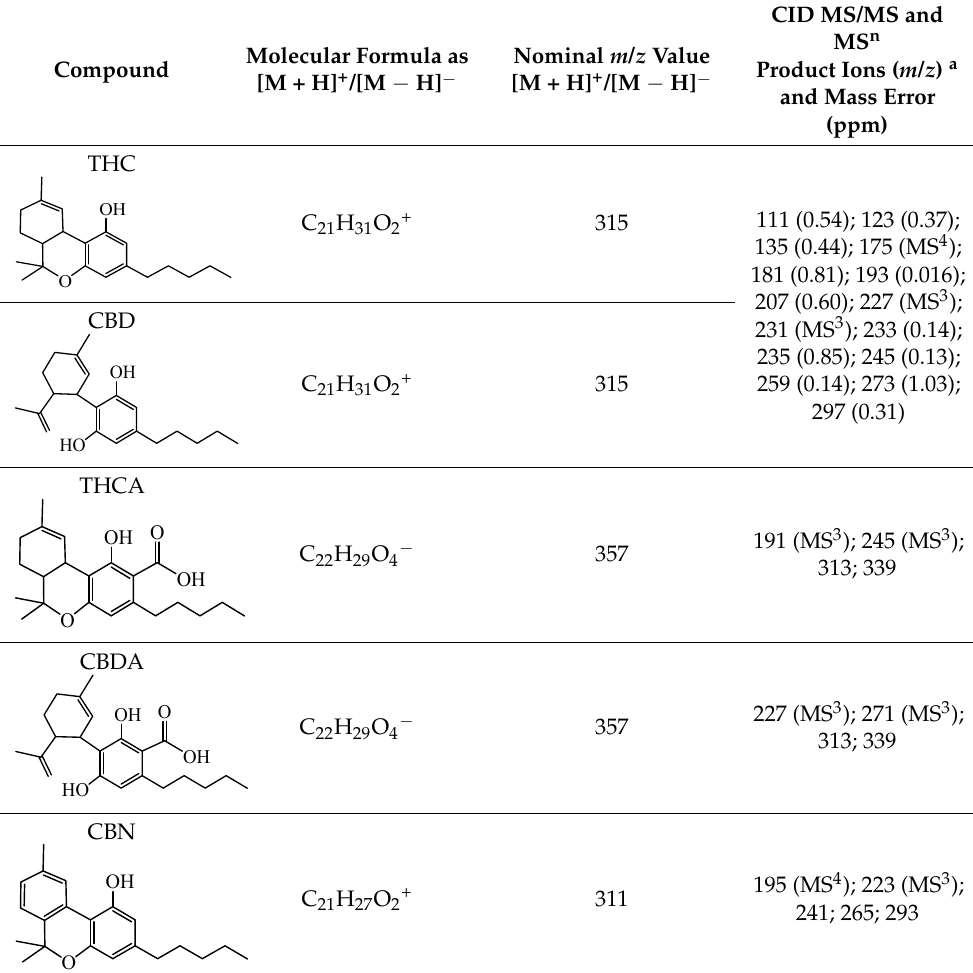
Table 2. Cannabinoids occurring in a sample of light Cannabis sativa extract understudy, identified as intact protonated molecules, [M + H] + for THC, CBD, and CBN, and intact deprotonated molecules, [M − H] − , for THCA and CBDA, by using LC-ESI-LTQ MS n and collision-induced dissociation (CID) as a fragmentation technique.